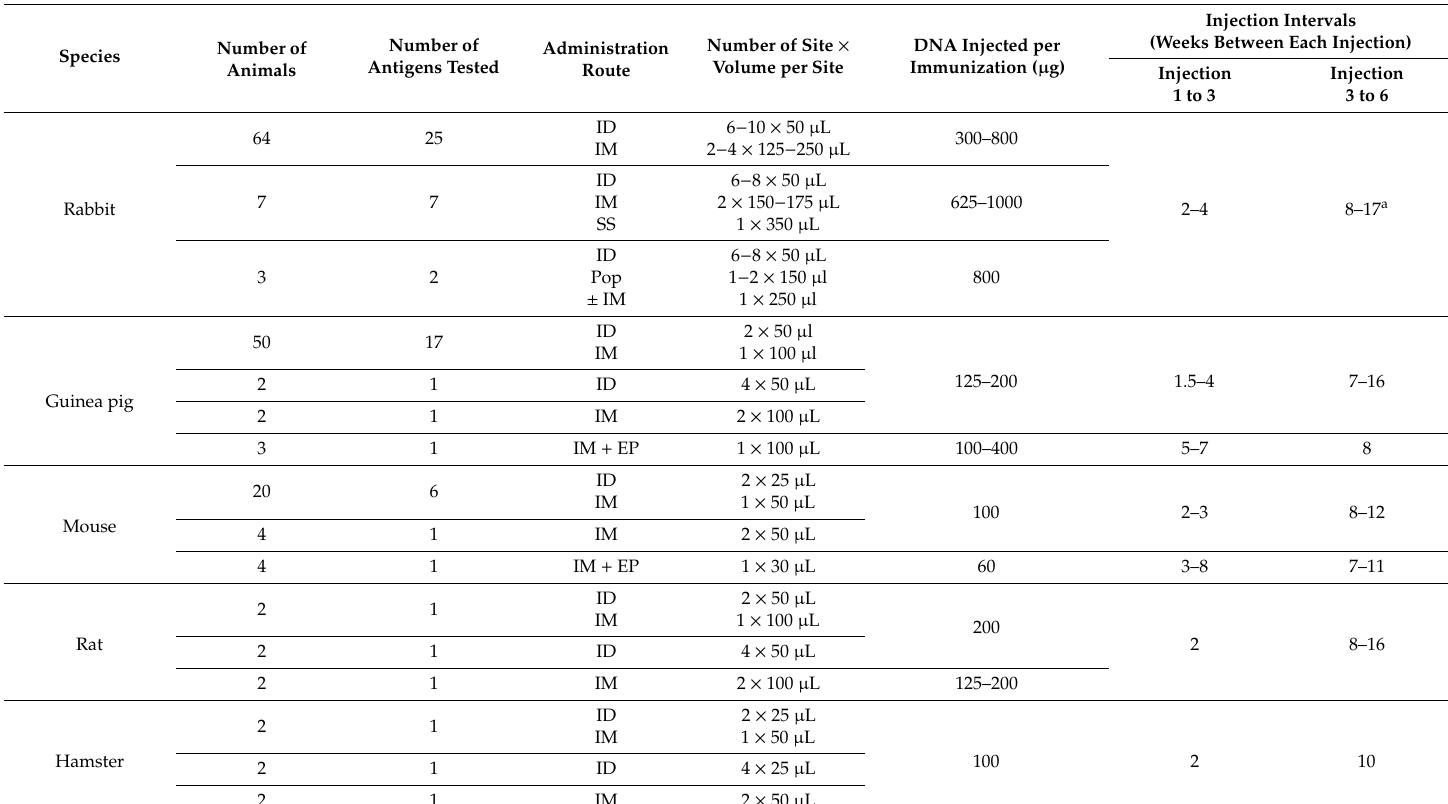
Table 1. Immunization protocol